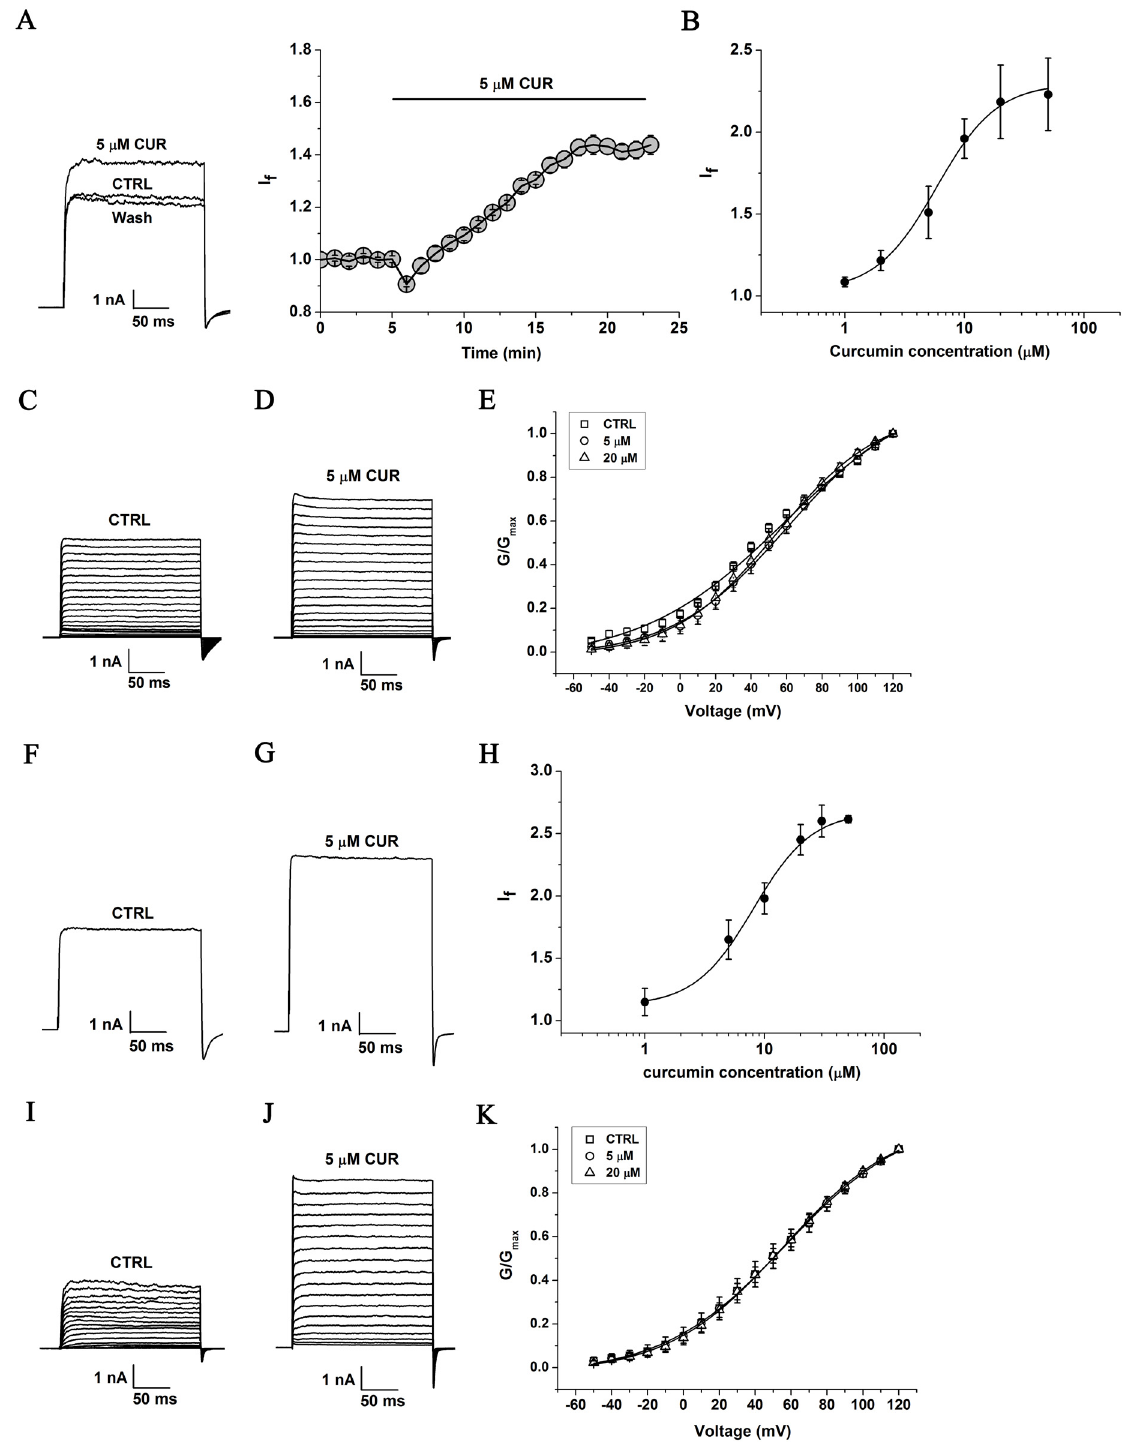
Fig 1. Effect of curcumin on exogenous BK ( α ) channel currents in HEK293 cells. (A) Representative whole cell current traces from HEK293 cells expressing BK channels before and after the perfusion of 5 μ M curcumin (left) and the time course of the enhancement on BK ( α ) channels by of curcumin (right). With 3 μ M free Ca 2+ in the pipette solution, the holding voltage was controlled at -80 mV and BK currents were evoked by the pulse of +100 mV. (B) The dose-dependence curve of curcumin enhancing BK currents was fitted by the Hill equation (see “ Data analysis ” ). The EC 50 value is 5.83 ± 0.76 μ M with a Hill coefficient of n = 1.71 ± 0.30 (n = 8). (C) HEK293 cells were held at -80 mV, and the duration of 200 ms voltage steps were applied from -50 to +120 mV at